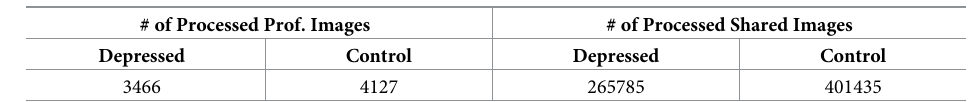
Table 3. Statistics of processed shared/profile